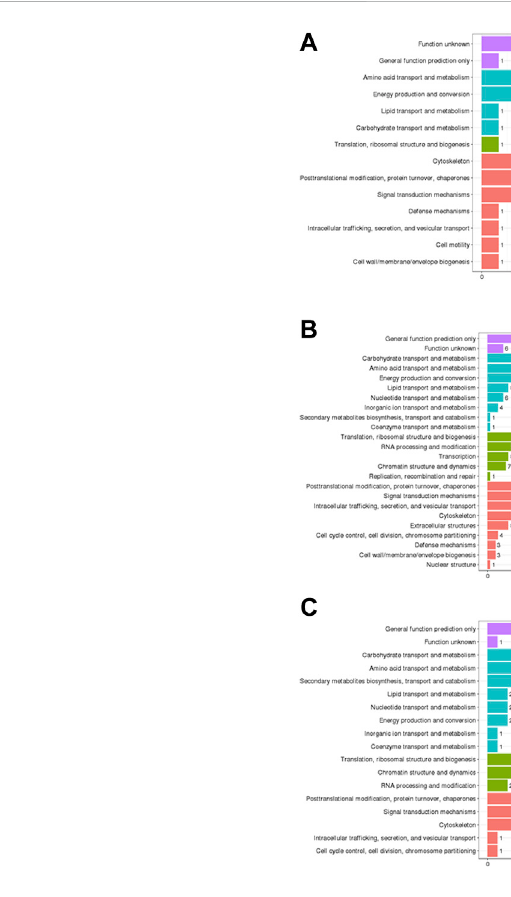
FIGURE 4 Barplot of the KOG analysis. (A) experiment II vs. experiment I, (B) control II vs. control I, (C) experiment II vs. control II. Eukaryotic orthologous groups (KOGs) were delineated by comparing protein sequences encoded in complete genomes, representing major phylogenetic lineages. X -axis displays the KOG term, y -axis displays the corresponding protein count illustrating the protein number of different